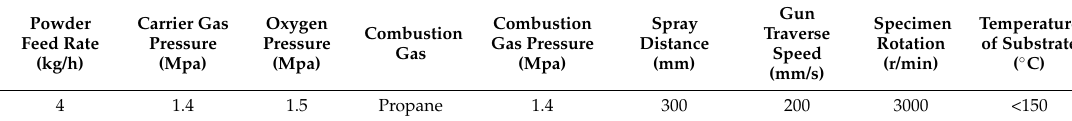
Table 1. Spray parameters of high velocity oxygen fuel (HVOF).